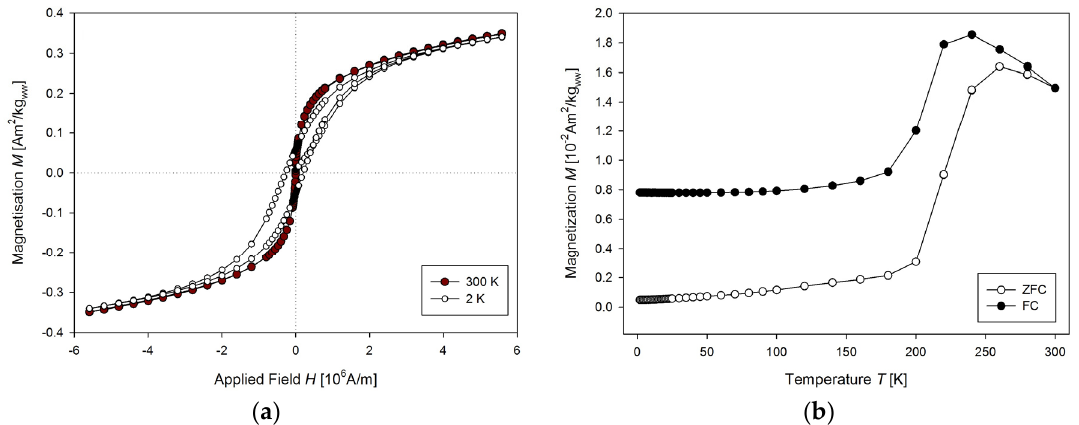
Figure 9. Properties of USPION dispersion per se. ( a ) The mass magnetisation vs. the applied magnetic field measured at 2 and 300 K. ( b ) The mass magnetisation vs. the temperature measured at 4000 A/m applied magnetic field.